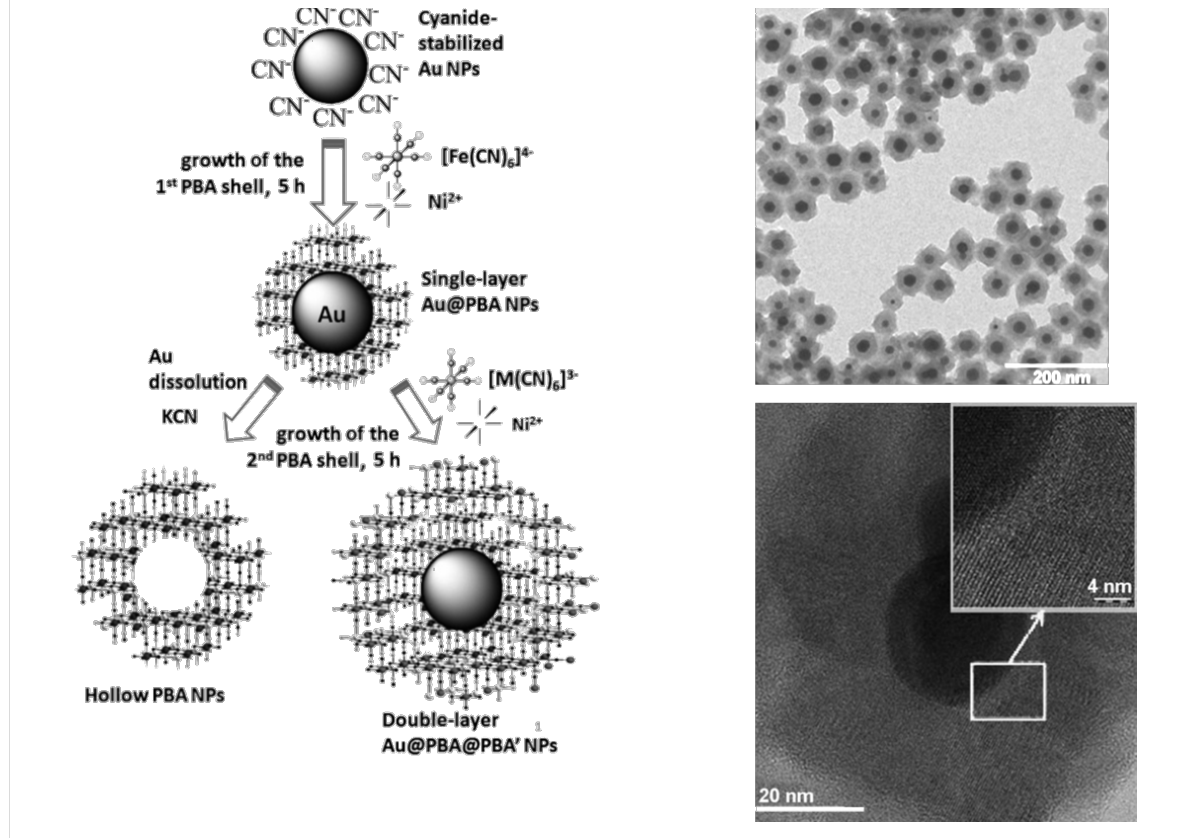
Figure 4: Schematic representation of single layer Au@PBA nanoparticles, double layer Au@PBA@PBA core–shell NPs, and hollow PBA NPs. On the right, TEM and HRTEM images of the Au@KNiFe NPs. Adapted with permission from [25], copyright 2014 Wiley-VCH.